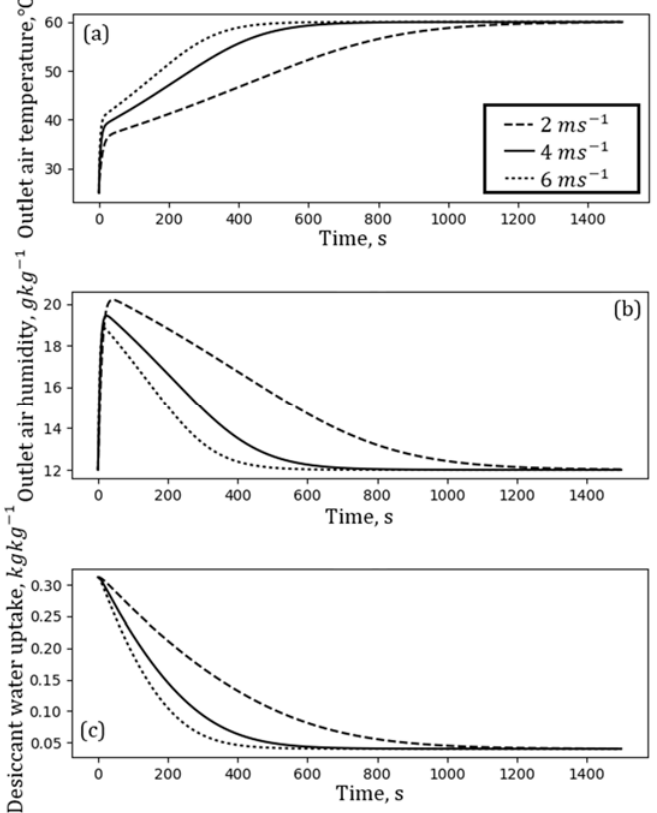
Figure 10. The influence of superficial air velocity on desorption characteristics: ( a ) Outlet air temperature; ( b ) Outlet air humidity; ( c ) Desiccant water uptake.